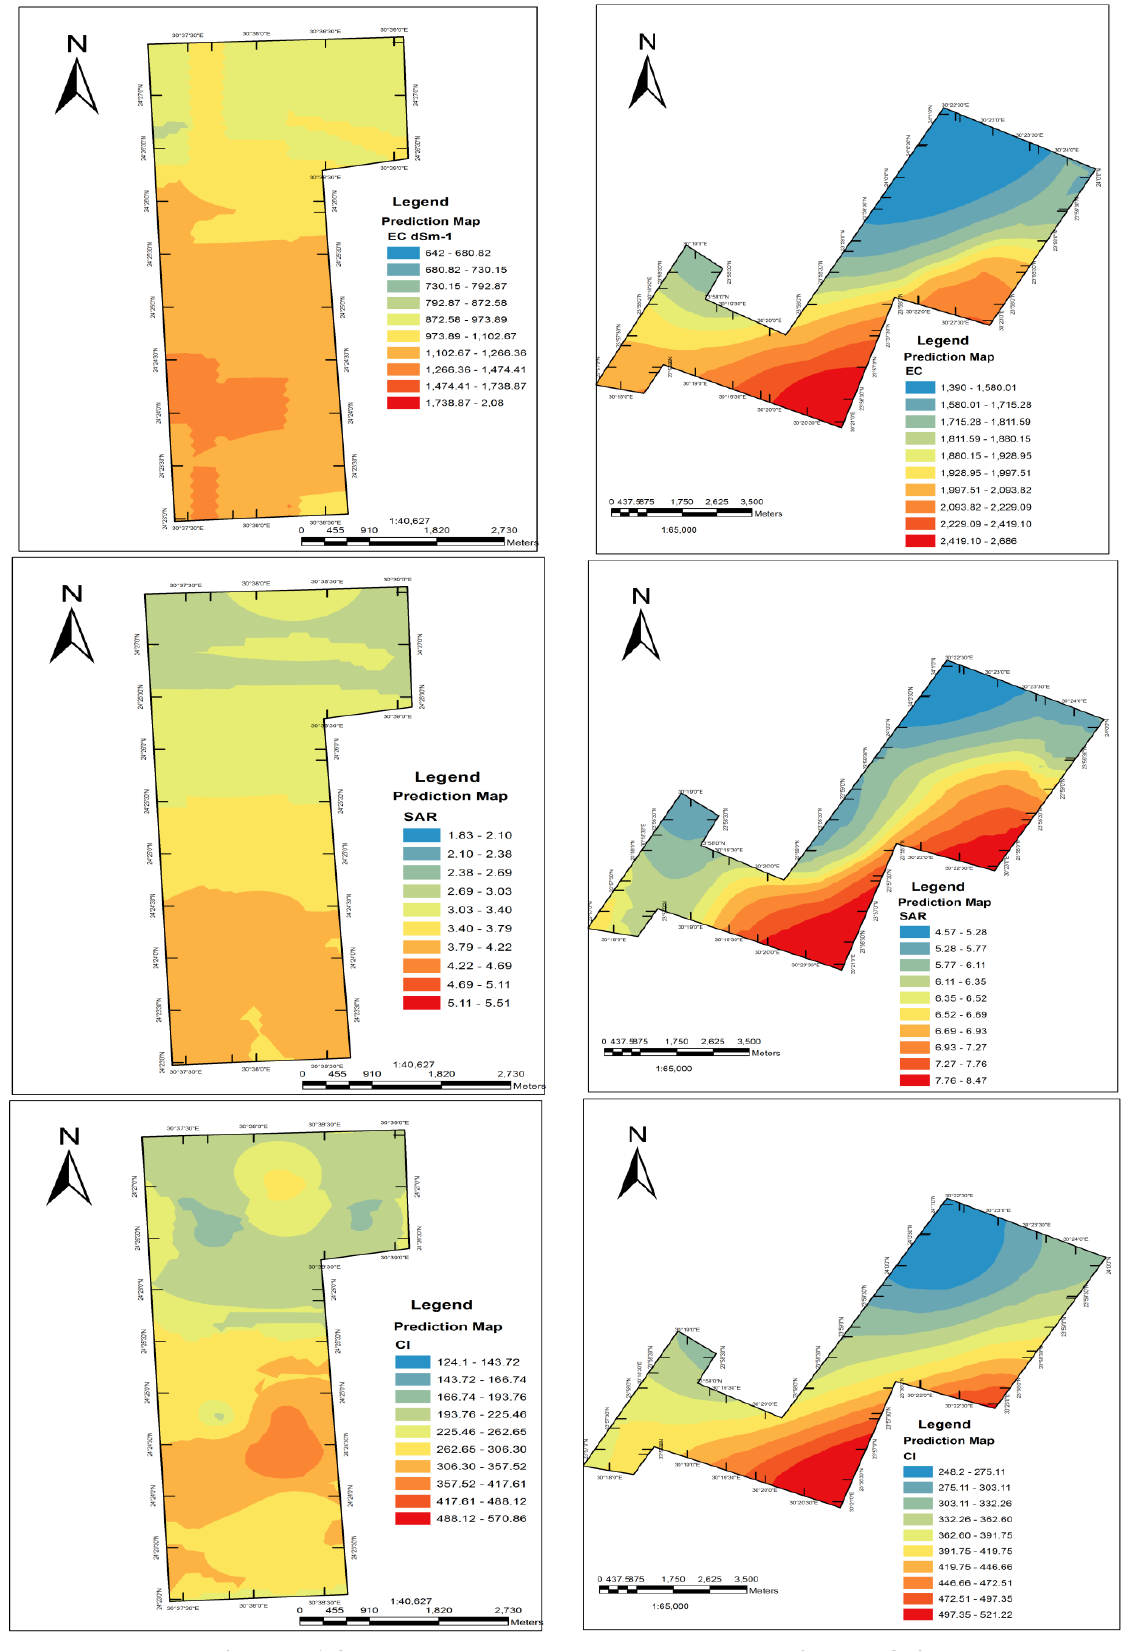
Villages 1,2 Villages